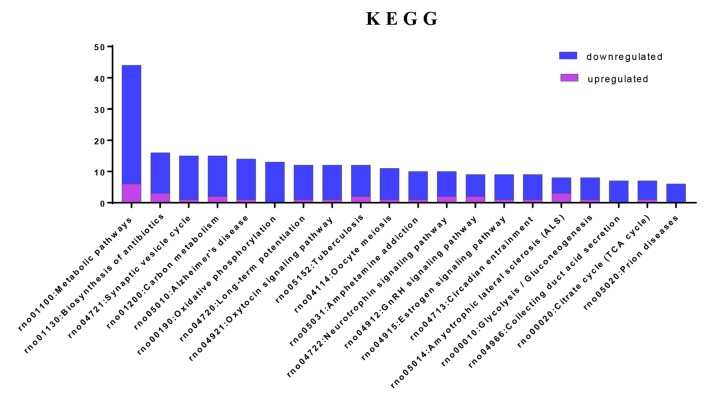
Enriched KEGG pathway analysis. Top 20 pathways were statistically siginificant with p-values < 0.05.